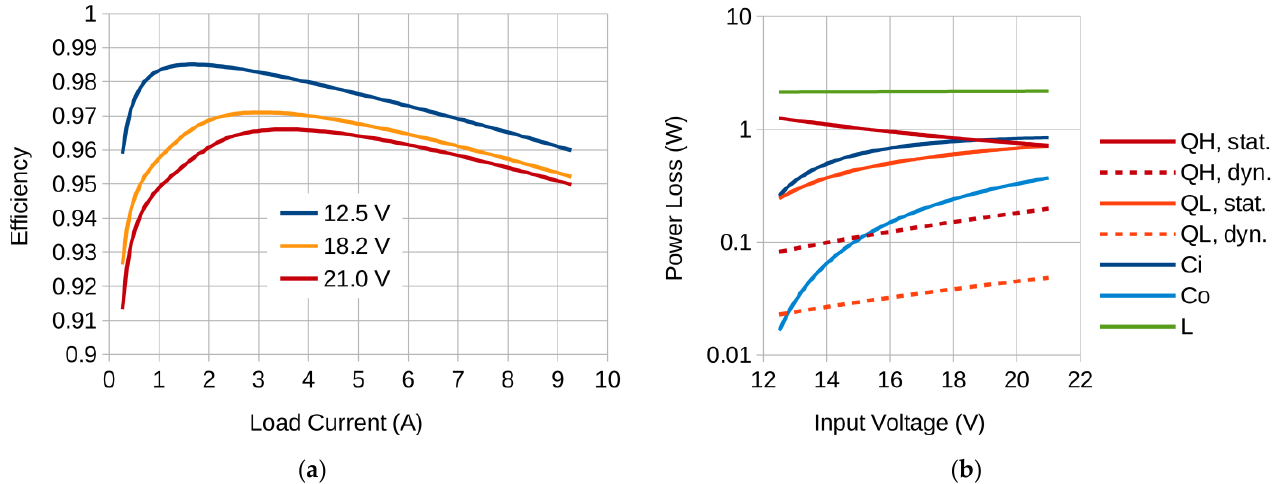
Figure 3. Simulated MPC characteristics: ( a ) Efficiency as a function of the load current for different input voltages; ( b ) Component power losses as functions of the input voltage for the maximum load current.